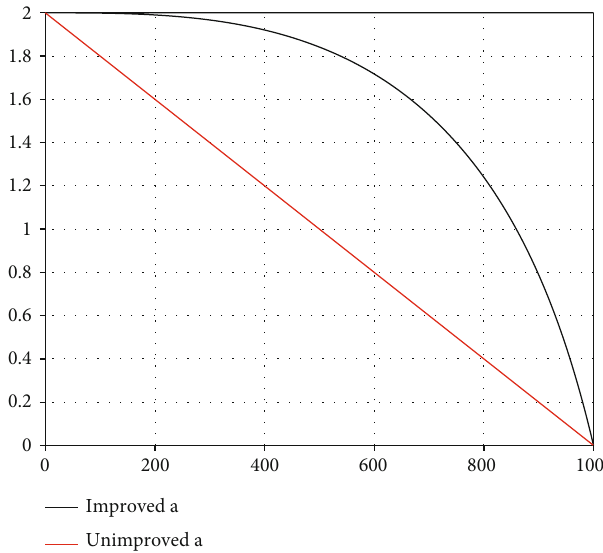
Figure 4: Convergence factor change